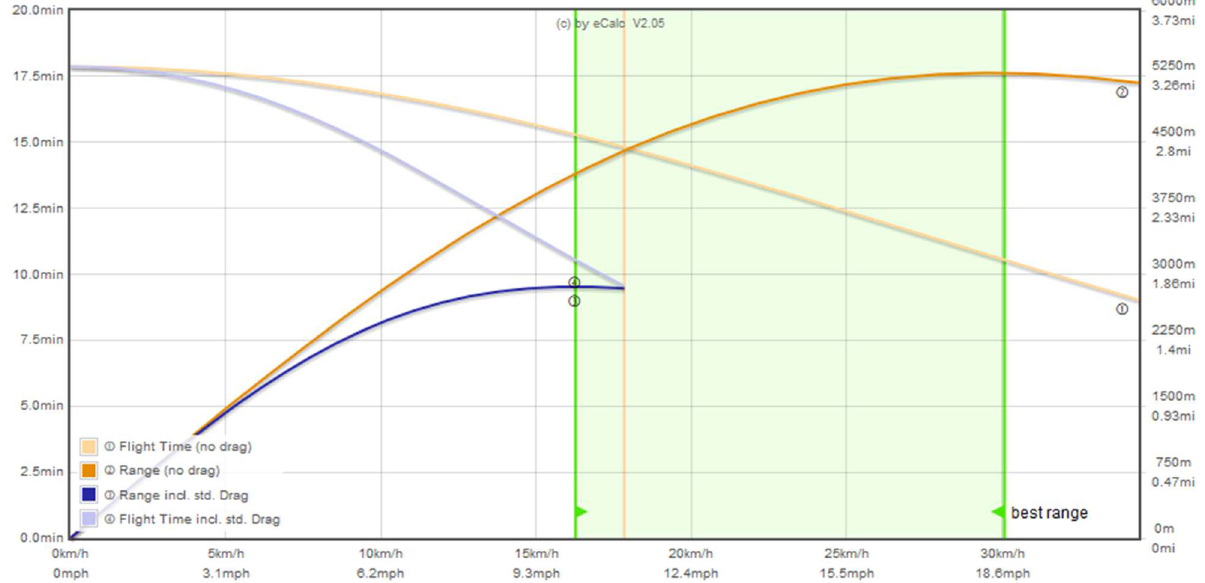
Figure 10. Simulated flight time and distance graph for the survey hexacopter build.